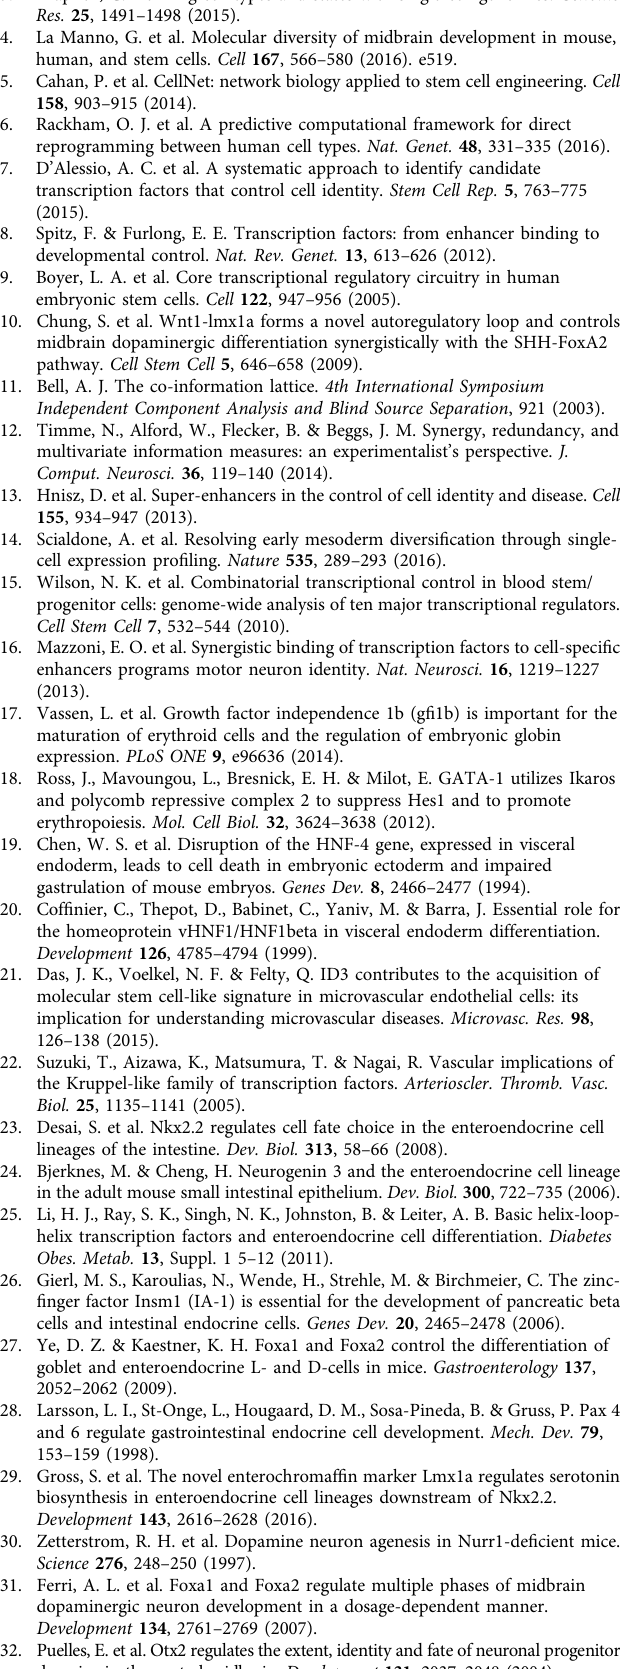
RT-qPCR . RNA was extracted form Lt-NES SAI2 cells using RNeASY mRNA isolation system (Qiagen) according to the manufacturer ’ s instructions and treated with DNAse on-column protocol. 200 – 500ng of total RNA were reverse- transcribed using the Superscript II kit (Invitrogen). The reverse-transcribed cDNA was ampli fi ed using Fast SYBRGREEN (Applied Biosystems) in a StepONE plus real time-qPCR machine (Applied Biosystems). Outliers were detected by using the absolute deviation from the median, statistical signi fi cance was measured with the Welch two sample two tailed t -test and Bonferroni correction in case of multiple testing. Stars indicate * P ≤ 0,05; ** P ≤ 0,01; *** P ≤ 0,001. Primers used in our analysis: